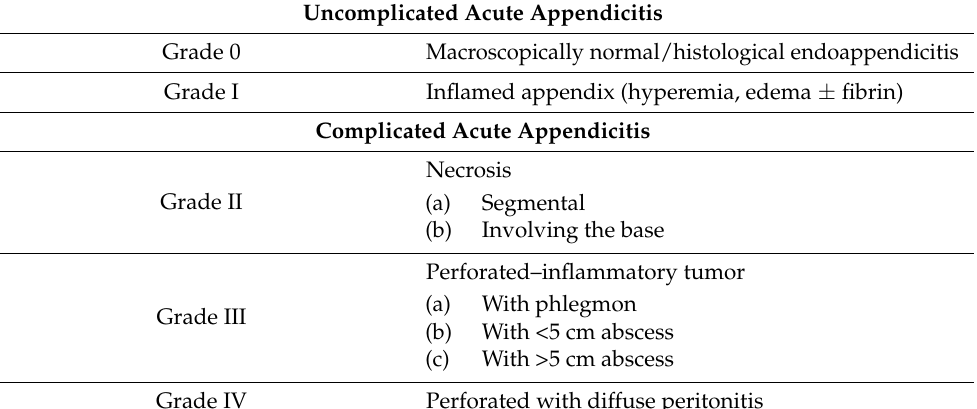
Table 1. Intraoperative appendicitis